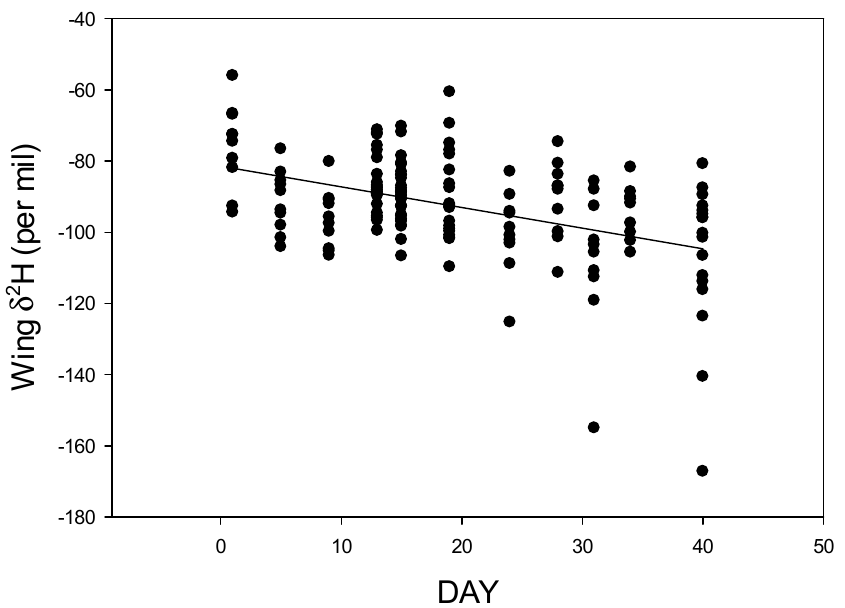
Figure 2. Relationship between wing δ 2 H and day of collection for Libytheana carinenta intercepted in fall migration 2019 in northeast Mexico. Y = − 0.58X − 81.4, r 2 = 0.2. Day 0 is 26 September.